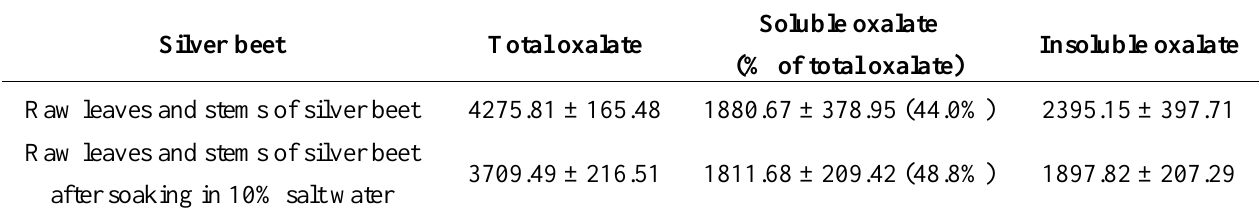
Table 2. Mean total soluble and insoluble oxalate contents of the raw and processed silver beet used to make kimchi (mg/100 g fresh